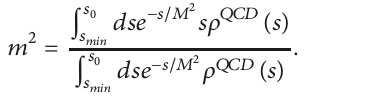
Table 1: Mass spectra of heavy-light mesons in MeV. QM denotes quark model and SR denotes sum rule calculations. The